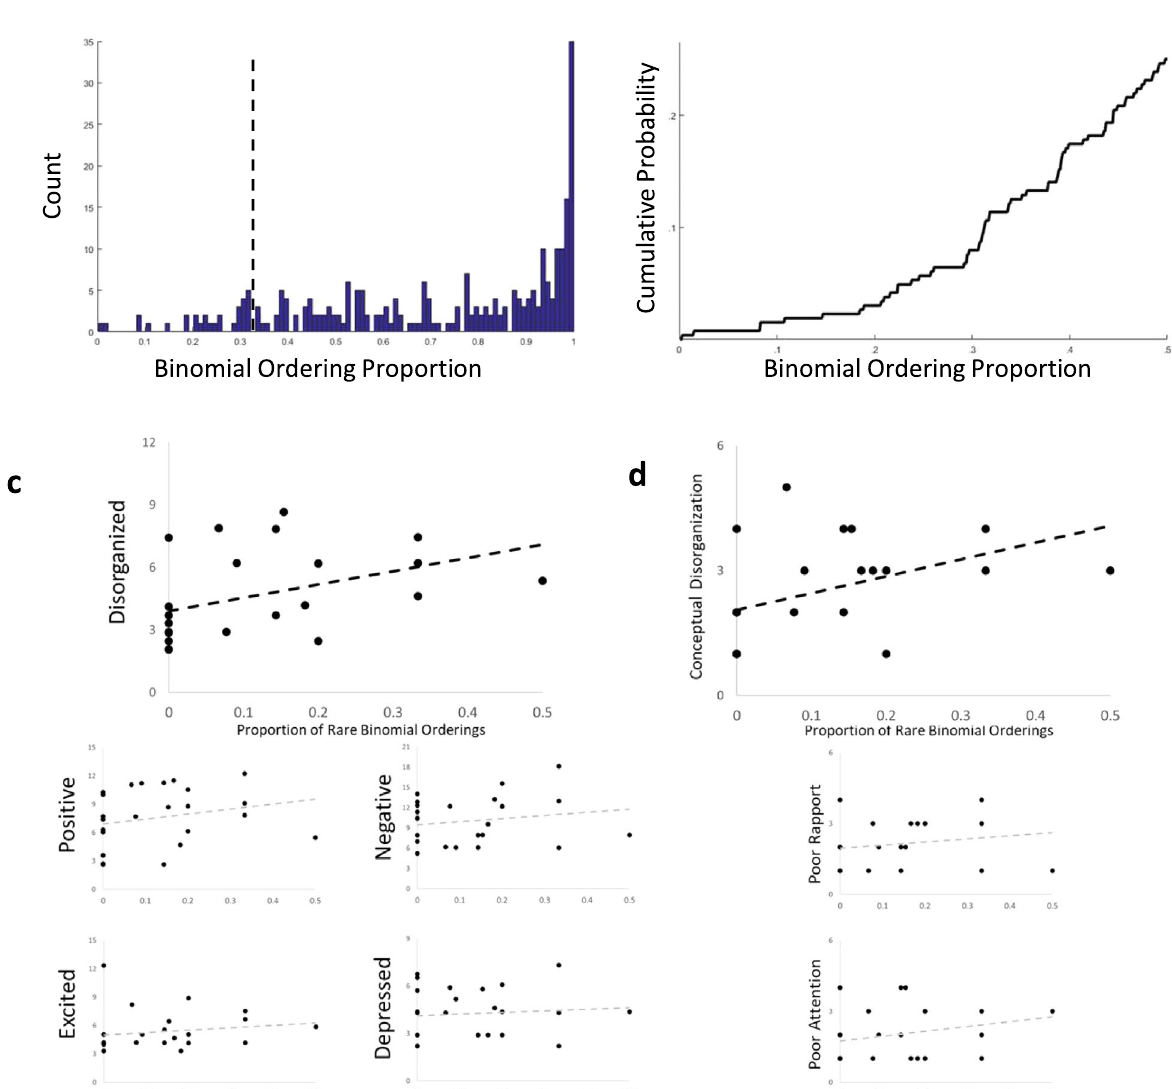
Fig. 1 Rare binomials are associated with thought disorder. a A histogram of the binomial ordering preference for all binomials across all subjects. The dotted line is at 0.33 and all binomials to the left of this line were considered to be rare binomials. b The cumulative probability of all binomial ordering preferences (up to 0.5) across all subjects. c Scatter plots between number of rare binomials, normalized by total number of binomials per transcript, and the factor scores. Only the black trendline (Disorganized Factor) is a statistically signi fi cant association. d Scatter plots showing the relationships between normalized rare binomial count and the three component PANSS items of the Disorganized Factor score. Only the Conceptual Disorganization item shows a statistically signi fi cant